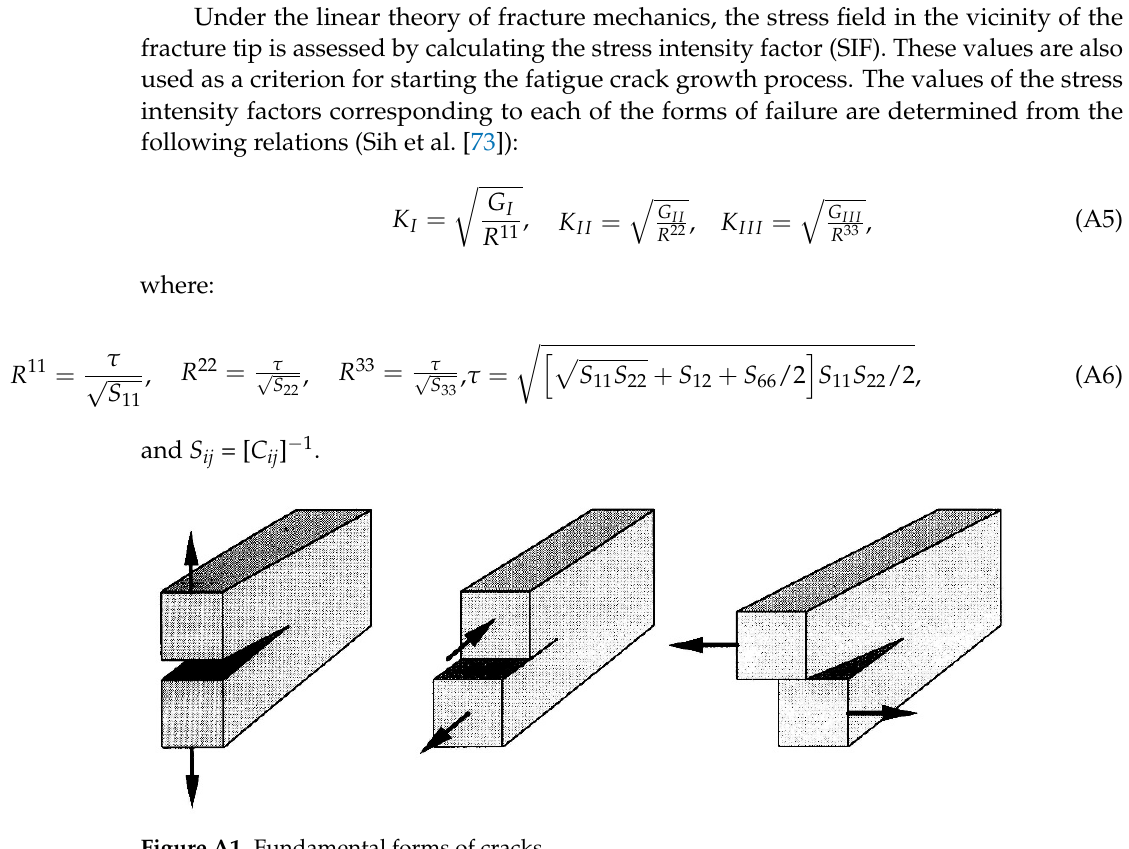
Figure A1. Fundamental forms of cracks.